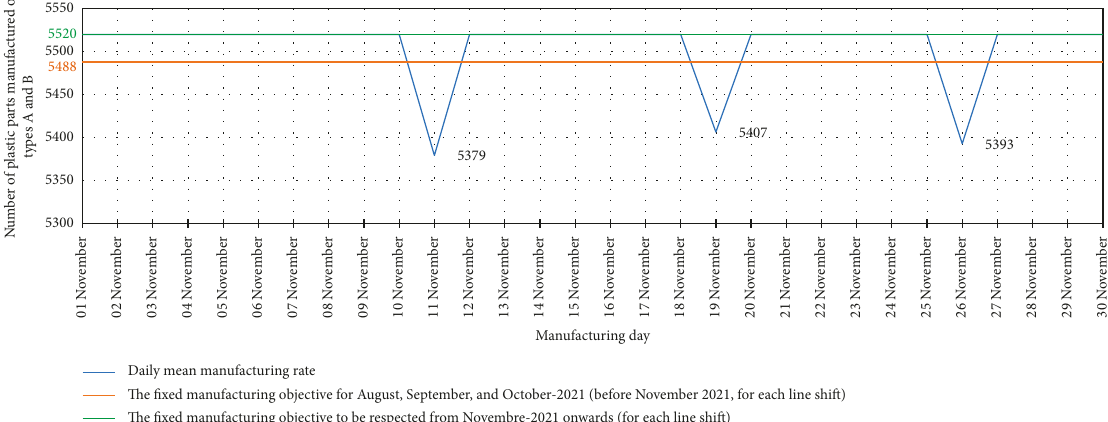
Figure 6: Daily mean manufacturing rate (during the optimal planned production time objectives before and from November 2021 (the former manufacturing objective and the new one)/November